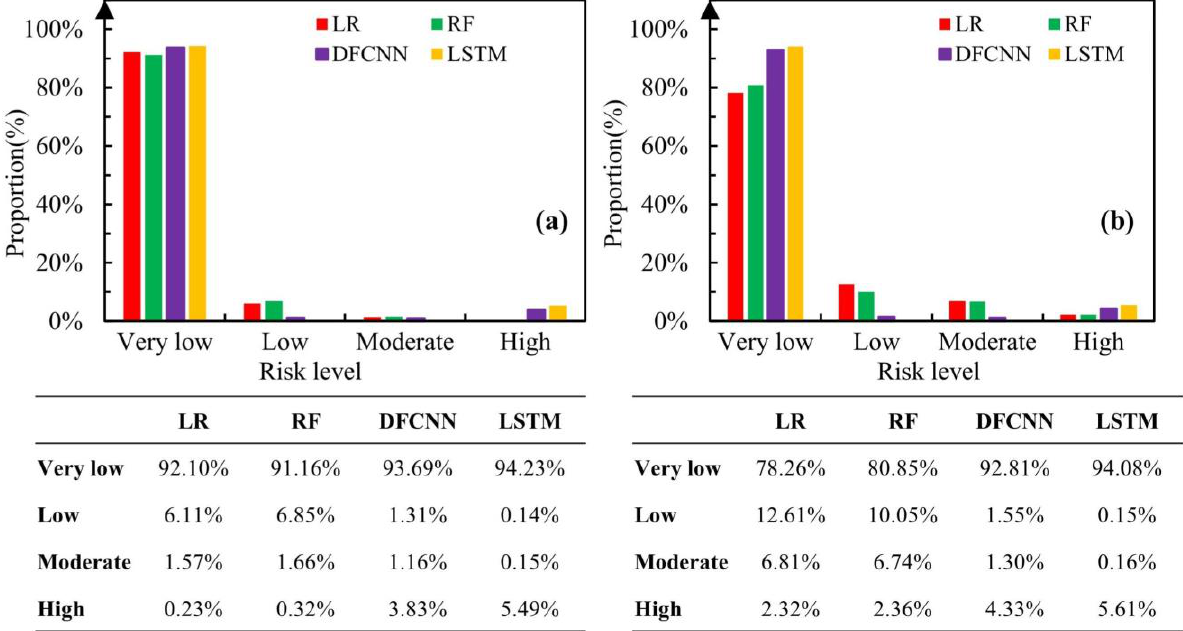
Figure 14. Proportions of different landslide risk levels of four models: ( a ) class imbalanced strategy, ( b ) class balanced strategy. ( b ) class balanced